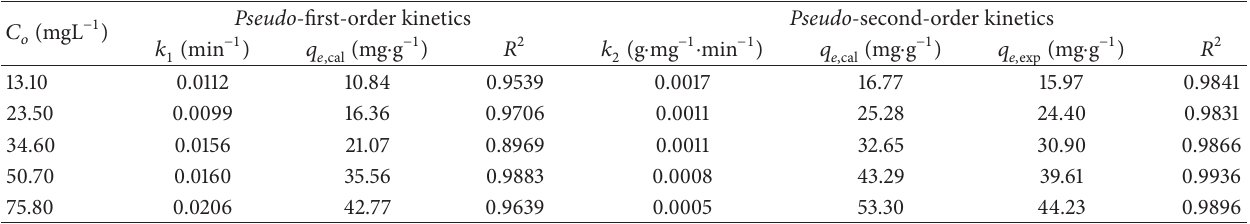
Table 1: Adsorption kinetic parameters for As(V) adsorption on the Fe 3 O 4 /rGO composite. −1 ) 𝐶 𝑜 (mgL